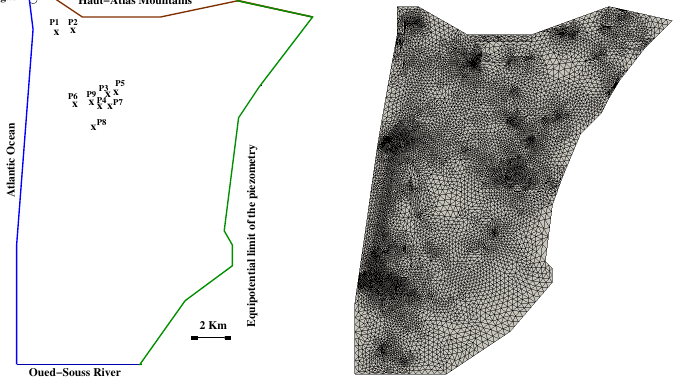
Figure 8. Left : Geometry and boundaries of the aquifer and well locations. Right : mesh for the